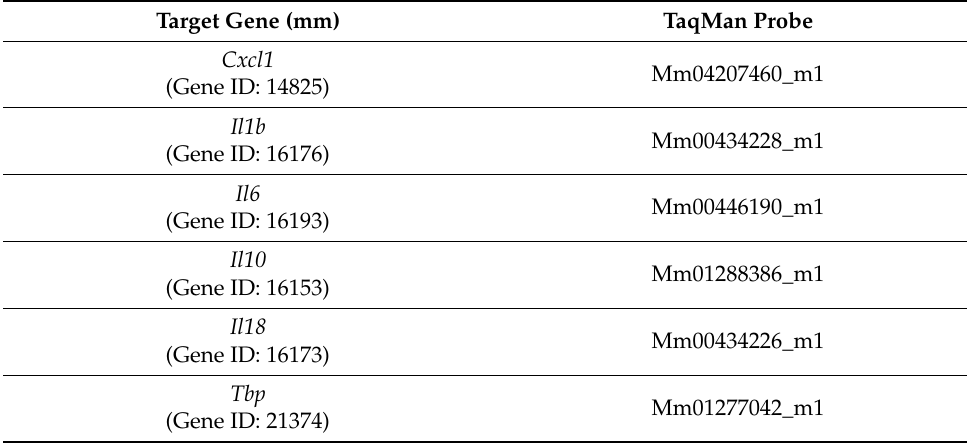
Table 2. The TaqMan TM probes used for